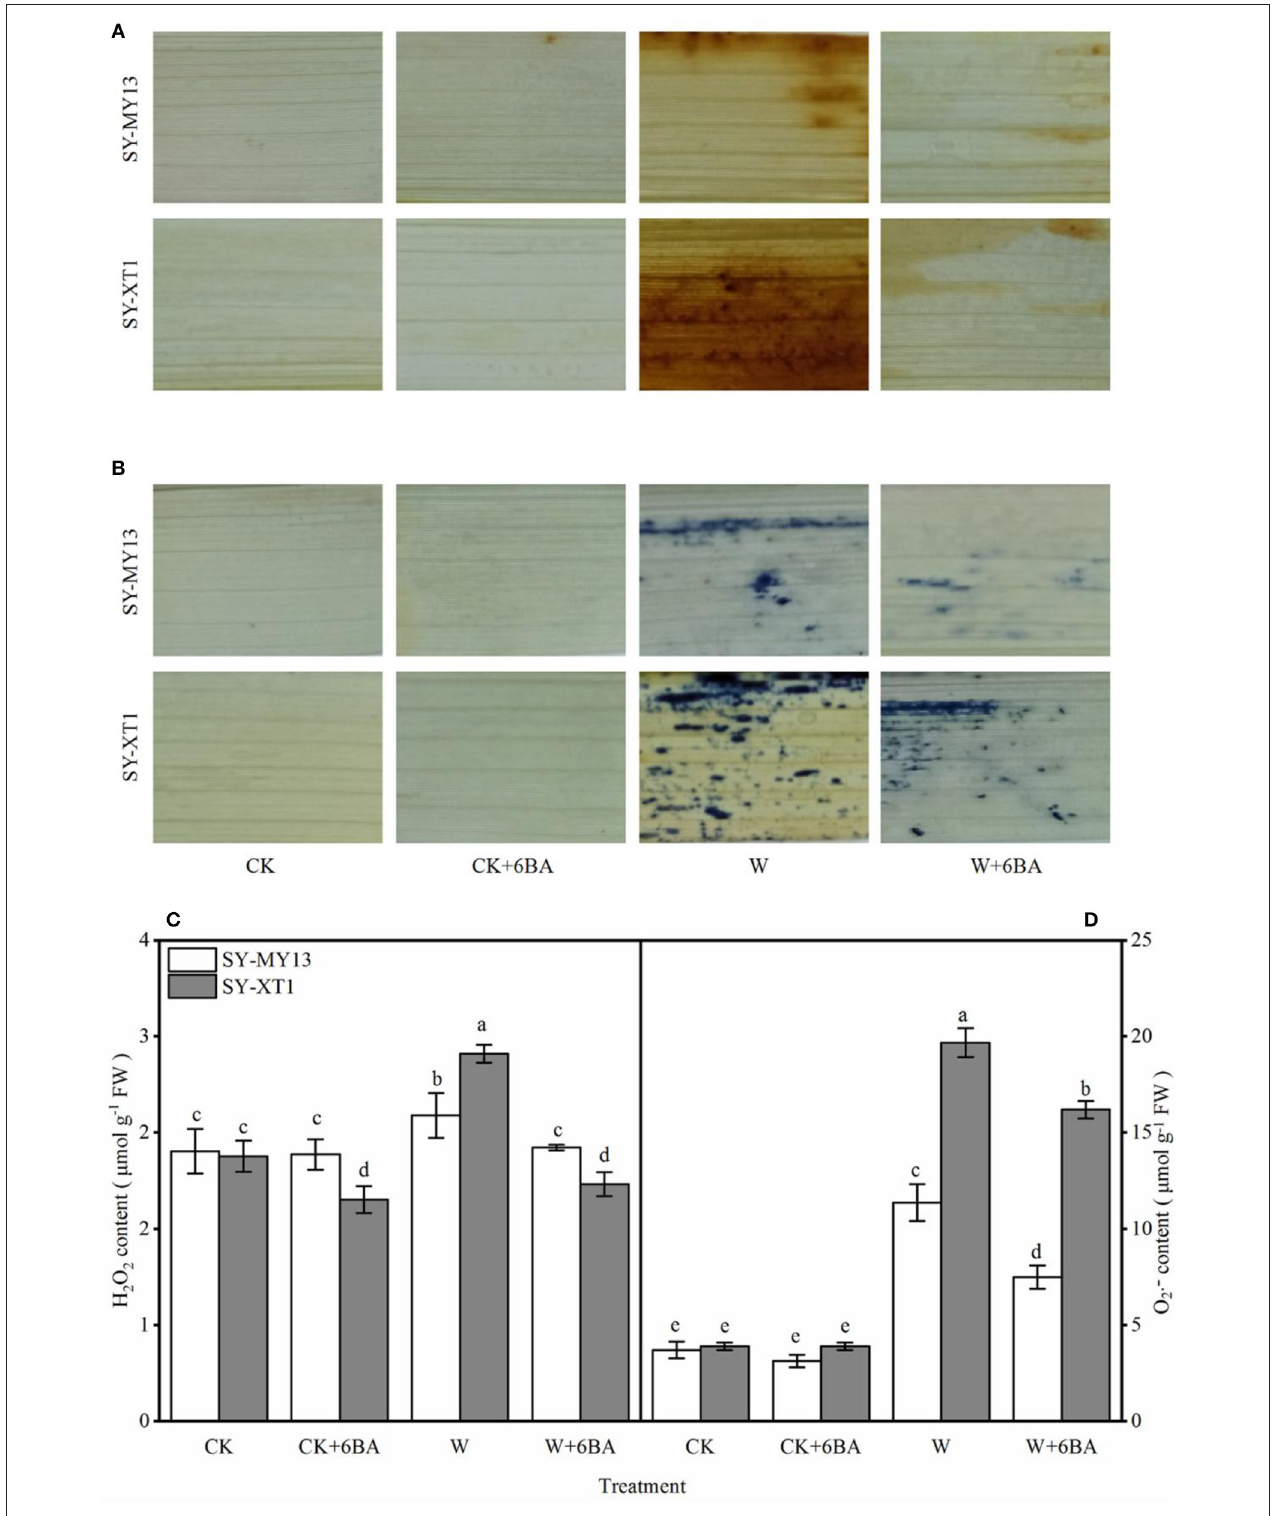
FIGURE 2 | Effects of 6-BA on histochemical staining of H 2 O 2 (A) and O − 2 (B) , Concentration of H 2 O 2 (C) and O − 2 (D) in two waxy corn inbred lines in waterlogged conditions. CK, normal watering conditions only; CK + 6-BA, 0.5mM of 6-BA plus normal watering conditions; W, waterlogged; W + 6-BA, Addition of 0.5mM of 6-BA plus waterlogging stress conditions. Data represent means ± SD of three replicates. For each variable, means with different lowercase letters were significantly different ( P < 0.05).